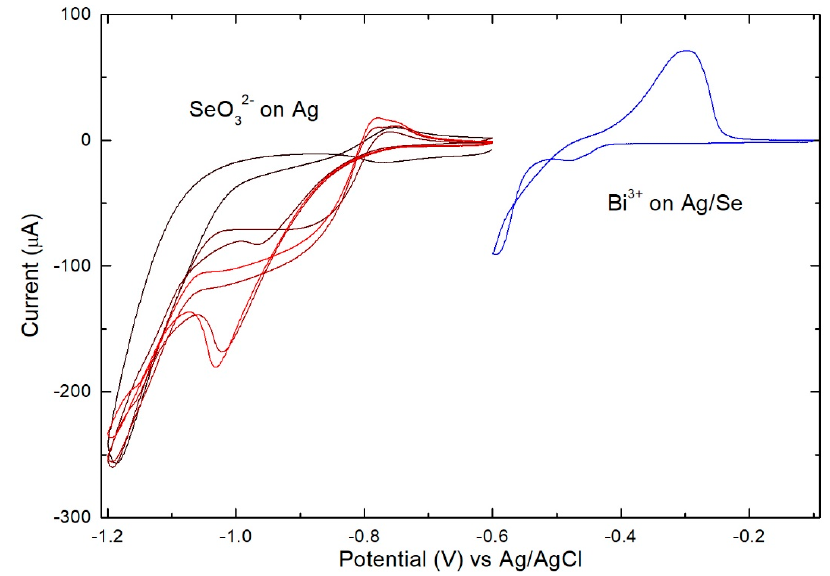
Figure 1. On the left: 4 consecutive CV of selenite (1st black–4th red) between − 0.6 and − 1.2 V, scan rate 50 mV/s. On the right: CV of the Bi solution on Ag/Se ad between − 0.1 and − 0.55 V at 10 mV/s.